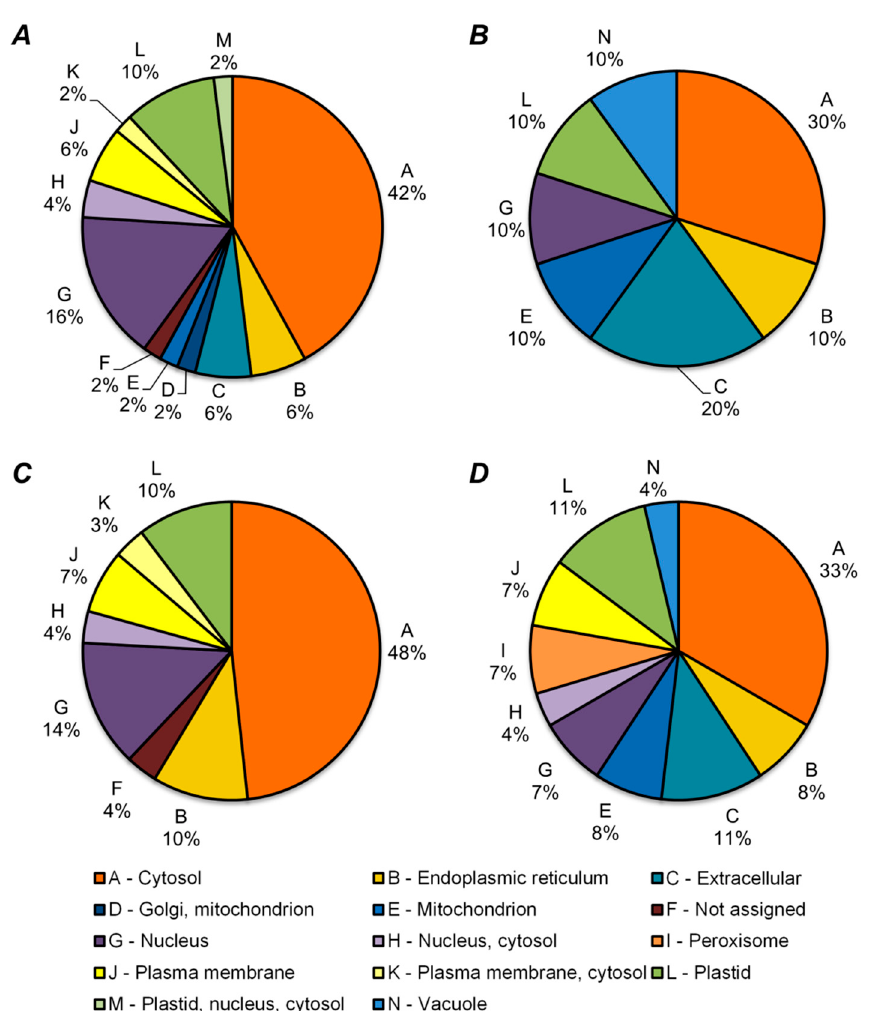
Figure 5. Sub-cellular localization annotation of differentially expressed proteins of seeds of pea ( P. sativum L) as accessed in Progenesis QIP (ANOVA, p ≤ 0.05). A —proteins up-regulated within line K-8274; B —proteins down-regulated within line K-8274; C —proteins up-regulated within line